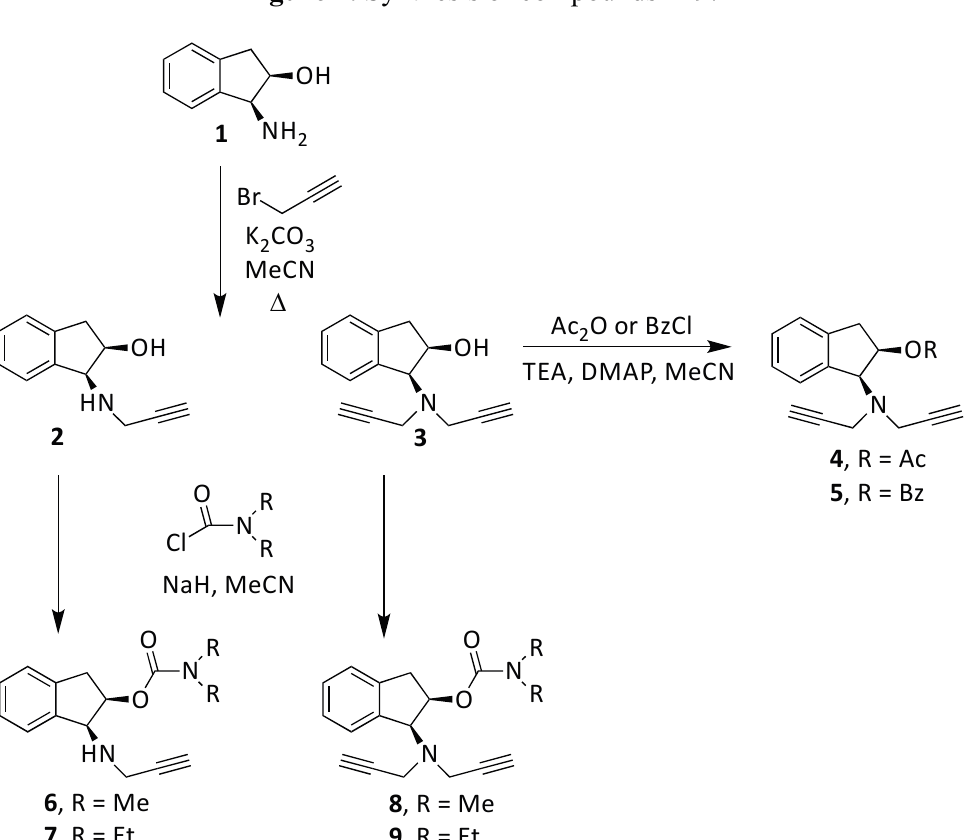
Figure 2. Synthesis of compounds 2 – 9